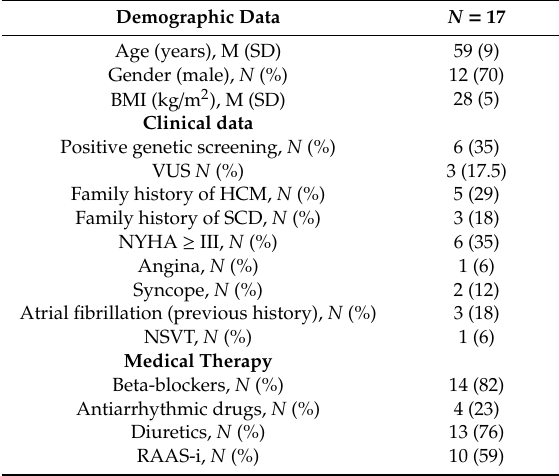
Table 1. Baseline characteristics of hypertrophic cardiomyopathy (HCM) patients.